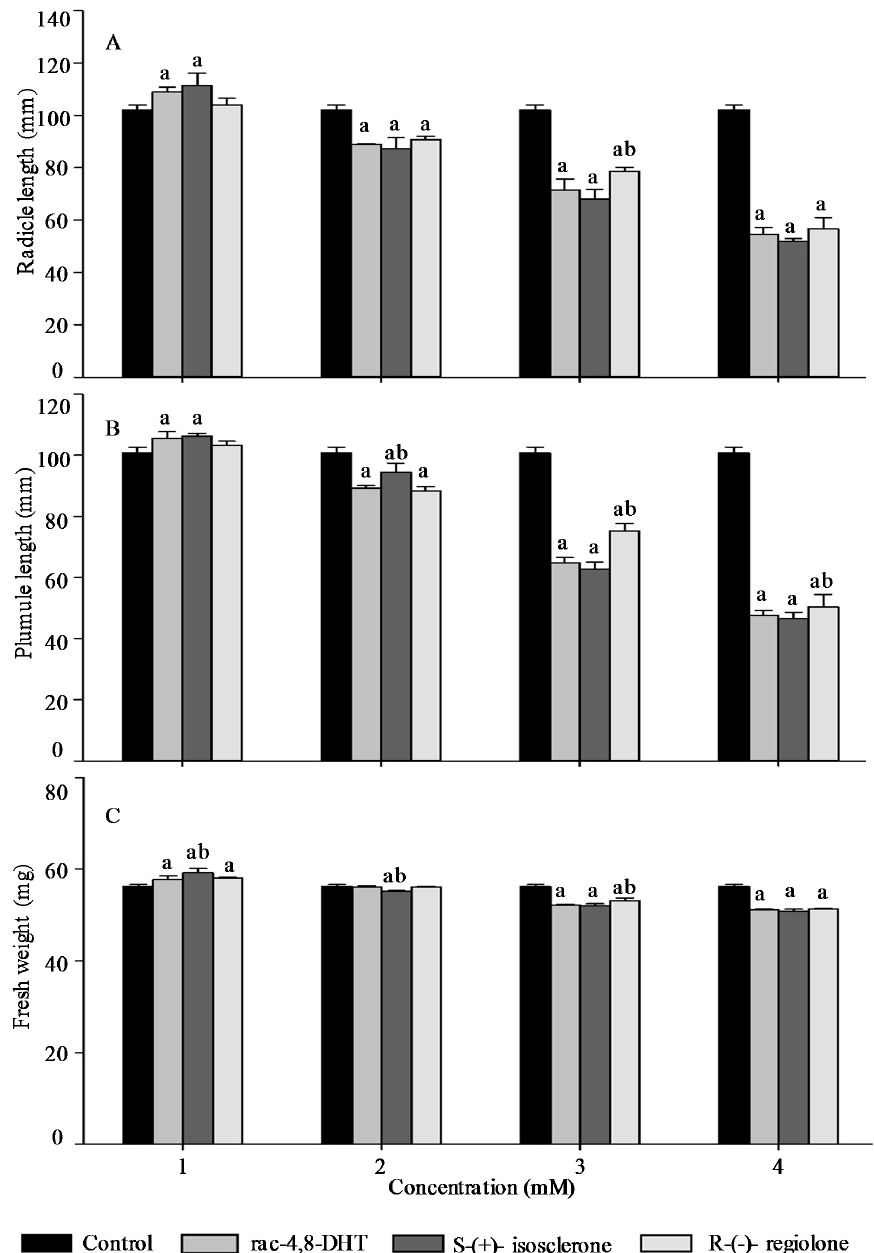
Figure 6. Effect of rac-4,8-DHT, S -(+)-isosclerone, and R -( − )-regiolone at different concentrations on radicle length ( A ); plumule length ( B ); and fresh weight ( C ) in wheat. a denotes a significant difference between control and treatments ( p < 0.05); b denotes a significant difference among rac-4,8-DHT, S -(+)-isosclerone and R -( − )-regiolone ( p < 0.05). It has been reported that enantioselective effect of paclobutrazol on Microcystis aeruginosa and Anabaena sp. was different. The (2 S ,3 S )-( − )-enantiomer showed stronger stimulatory activity on M. aeruginosa cyanobacteria than the (2 R ,3 R )-(+)-enantiomer, whereas the latter was a more potent stimulator of Anabaena sp. growth, indicating that enantioselectivity has specific effects on different organisms [8]. However, in this study, compared with the parameters of seedlings growth between